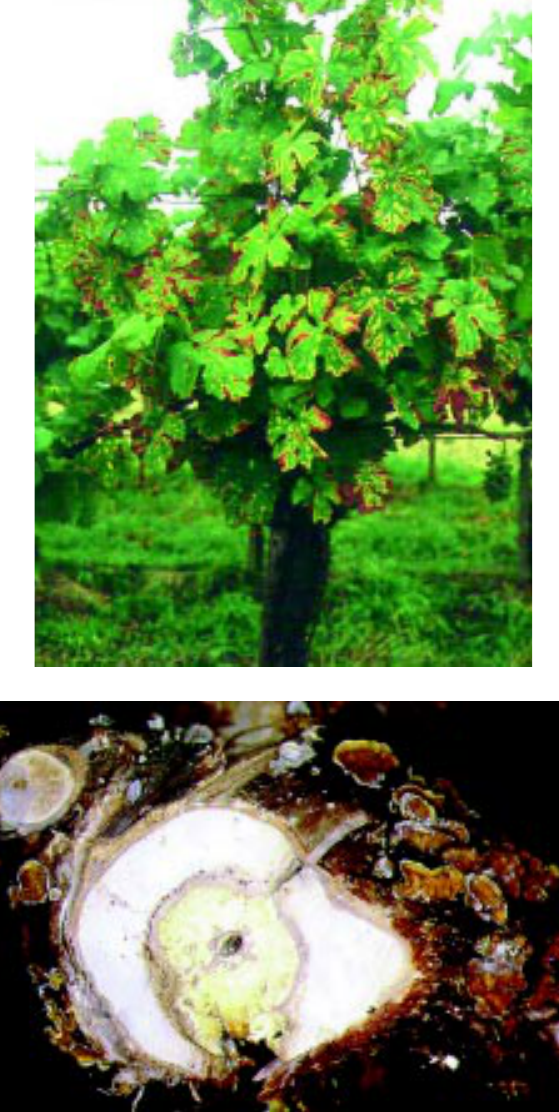
Fig. 3. A diseased vine with external esca symptoms (top) and cross section of the trunk with wood decay (white rot) and brown wood streaking; basidiocarps of Stereum hirsutum on the bark (bottom).